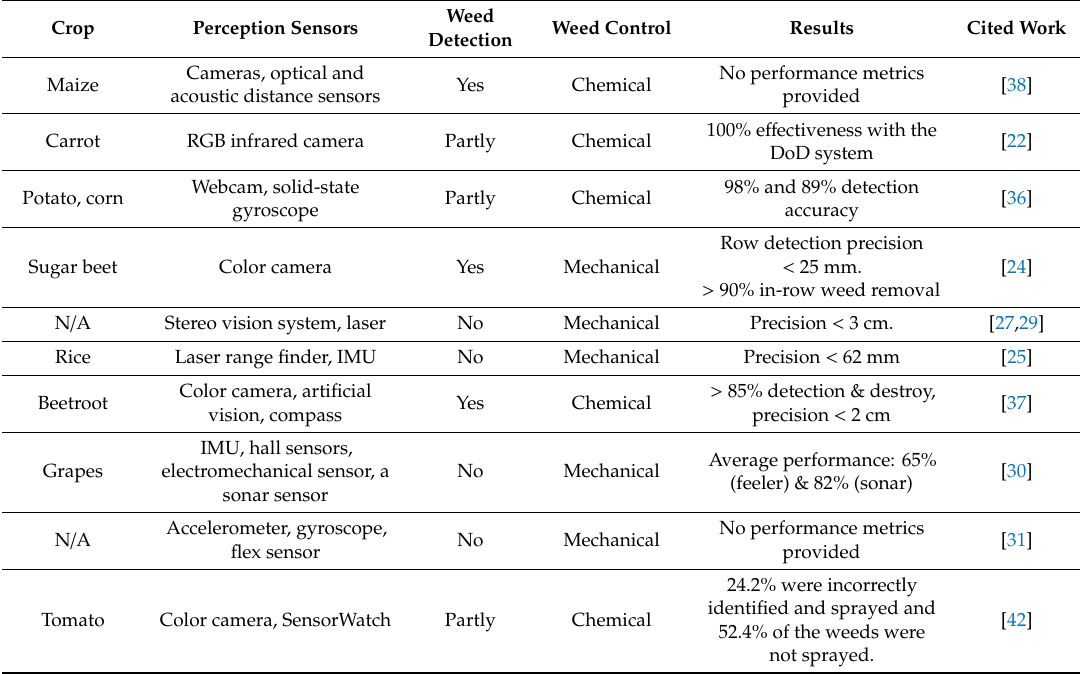
Table 1. Weeding agrirobotic systems’ characteristics for various